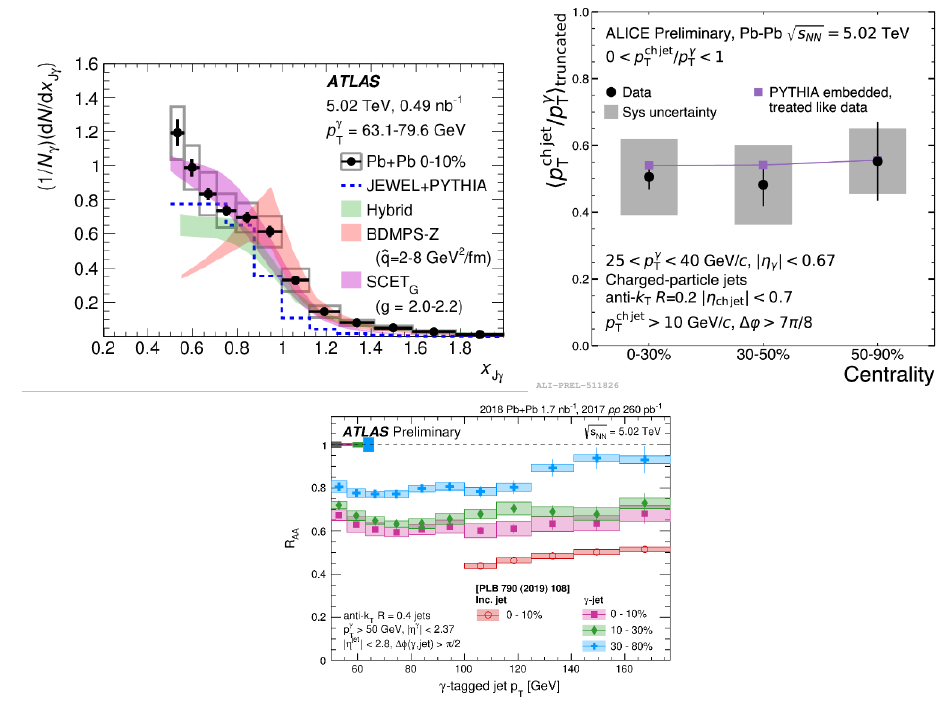
Figure 3. Top left: the momentum imbalance x j γ = p γ measured by ATLAS [15]. Top right: the truncated mean of the momentum imbalance x j γ = p γ measured by ALICE as a function of centrality. Bottom: The γ -tagged jet R AA as measured by ATLAS, compared with the inclusive jet R AA